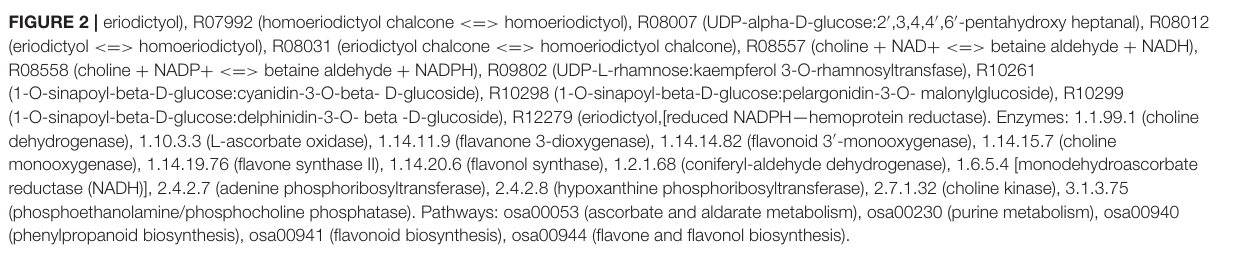
FIGURE 2 | eriodictyol), R07992 (homoeriodictyol chalcone < = > homoeriodictyol), R08007 (UDP-alpha-D-glucose:2 ′ ,3,4,4 ′ ,6 ′ -pentahydroxy heptanal), R08012 (eriodictyol < = > homoeriodictyol), R08031 (eriodictyol chalcone < = > homoeriodictyol chalcone), R08557 (choline + NAD + < = > betaine aldehyde + NADH), R08558 (choline + NADP + < = > betaine aldehyde + NADPH), R09802 (UDP-L-rhamnose:kaempferol 3-O-rhamnosyltransfase), R10261 (1-O-sinapoyl-beta-D-glucose:cyanidin-3-O-beta- D-glucoside), R10298 (1-O-sinapoyl-beta-D-glucose:pelargonidin-3-O- malonylglucoside), R10299 (1-O-sinapoyl-beta-D-glucose:delphinidin-3-O- beta -D-glucoside), R12279 (eriodictyol,[reduced NADPH—hemoprotein reductase). Enzymes: 1.1.99.1 (choline dehydrogenase), 1.10.3.3 (L-ascorbate oxidase), 1.14.11.9 (flavanone 3-dioxygenase), 1.14.14.82 (flavonoid 3 ′ -monooxygenase), 1.14.15.7 (choline monooxygenase), 1.14.19.76 (flavone synthase II), 1.14.20.6 (flavonol synthase), 1.2.1.68 (coniferyl-aldehyde dehydrogenase), 1.6.5.4 [monodehydroascorbate reductase (NADH)], 2.4.2.7 (adenine phosphoribosyltransferase), 2.4.2.8 (hypoxanthine phosphoribosyltransferase), 2.7.1.32 (choline kinase),